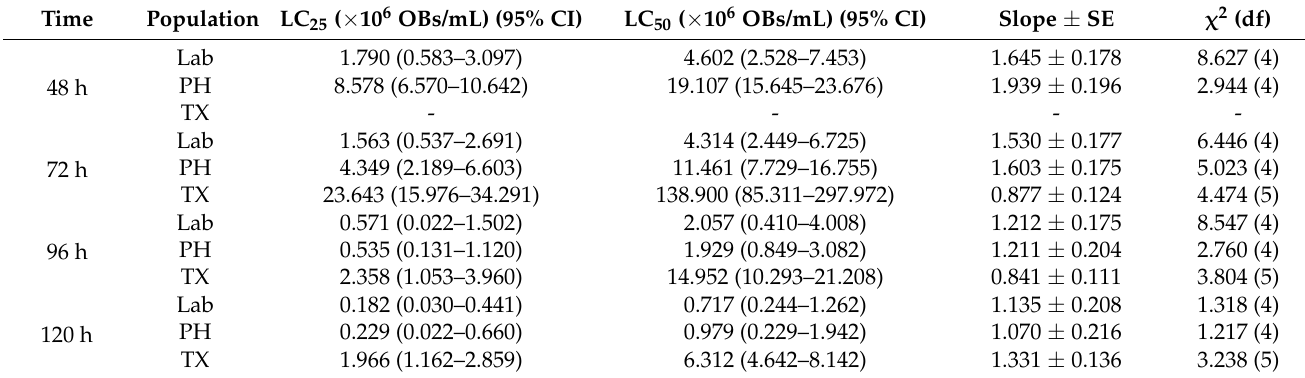
Table 4. Virulence of Spodoptera exigua multiple nucleopolyhedrovirus (SeMNPV) against three populations of S. exigua